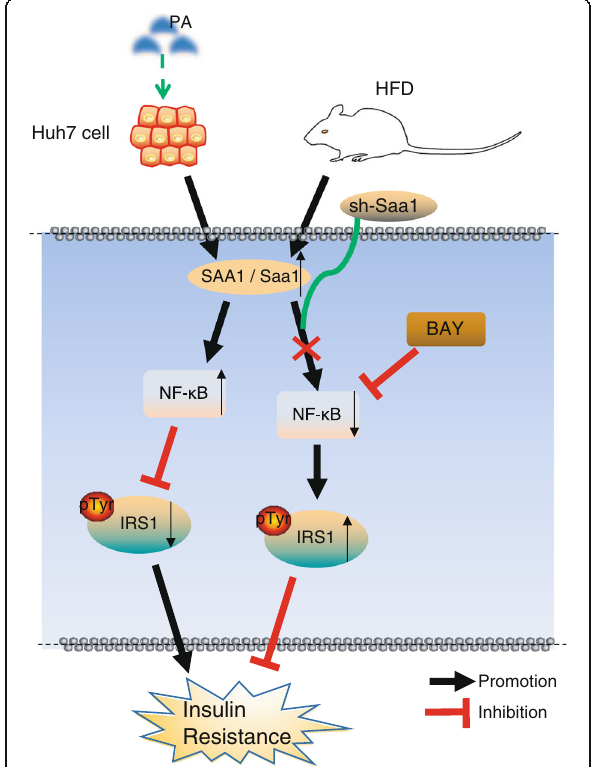
Fig. 6 Molecular mechanism map of SAA1 involved in insulin resistance by activating the NF- κ B pathway. SAA1 mediates PA- or HFD-induced insulin resistance though the activation of the NF- κ B pathway. In PA-or HFD-induced insulin resistance models, up-regulation of SAA1 could inhibit the activation of IRS1 signaling by activating the NF- κ B pathway, which contributes to insulin resistance. The silencing of SAA1 or treatment with BAY 11 – 7082 (NF- κ B inhibitor) can relieve PA- or HFD- induced insulin resistance by inhibiting the NF- κ B signaling pathway and IRS1 signaling. SAA1, serum amyloid A protein 1; IRS1, insulin receptor substrate 1; NF- κ B, nuclear factor- κ B; PA, palmitate; HFD, high-fat